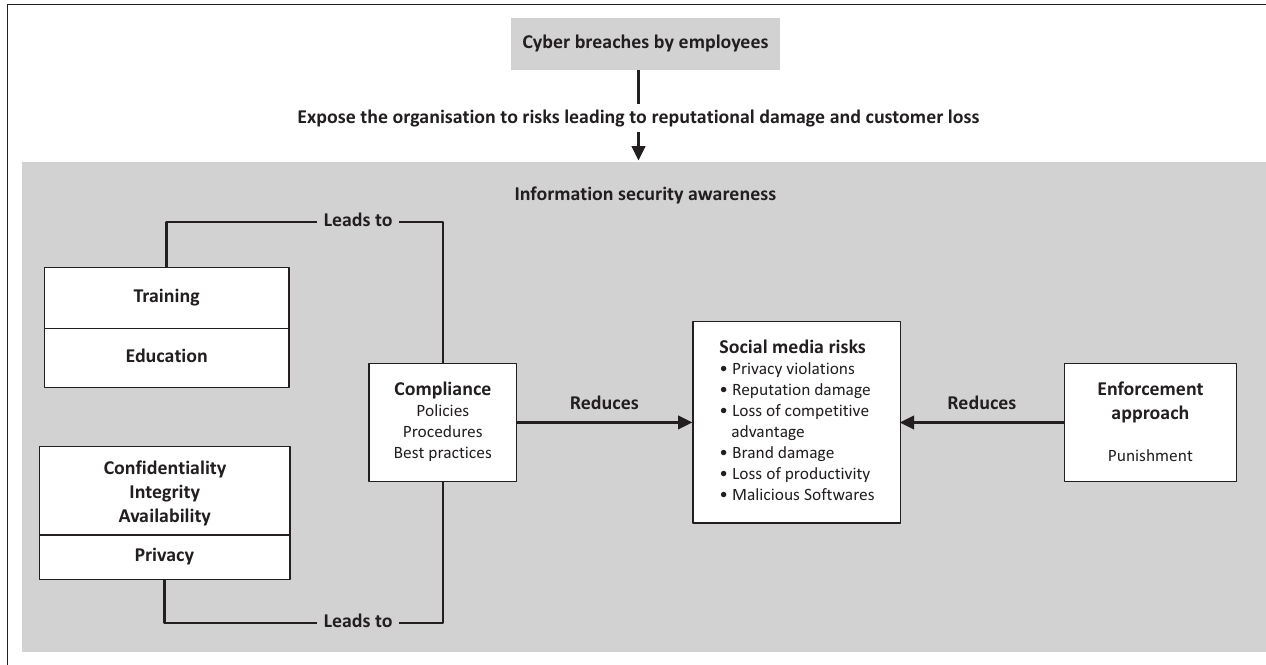
FIGURE 2: Information security awareness